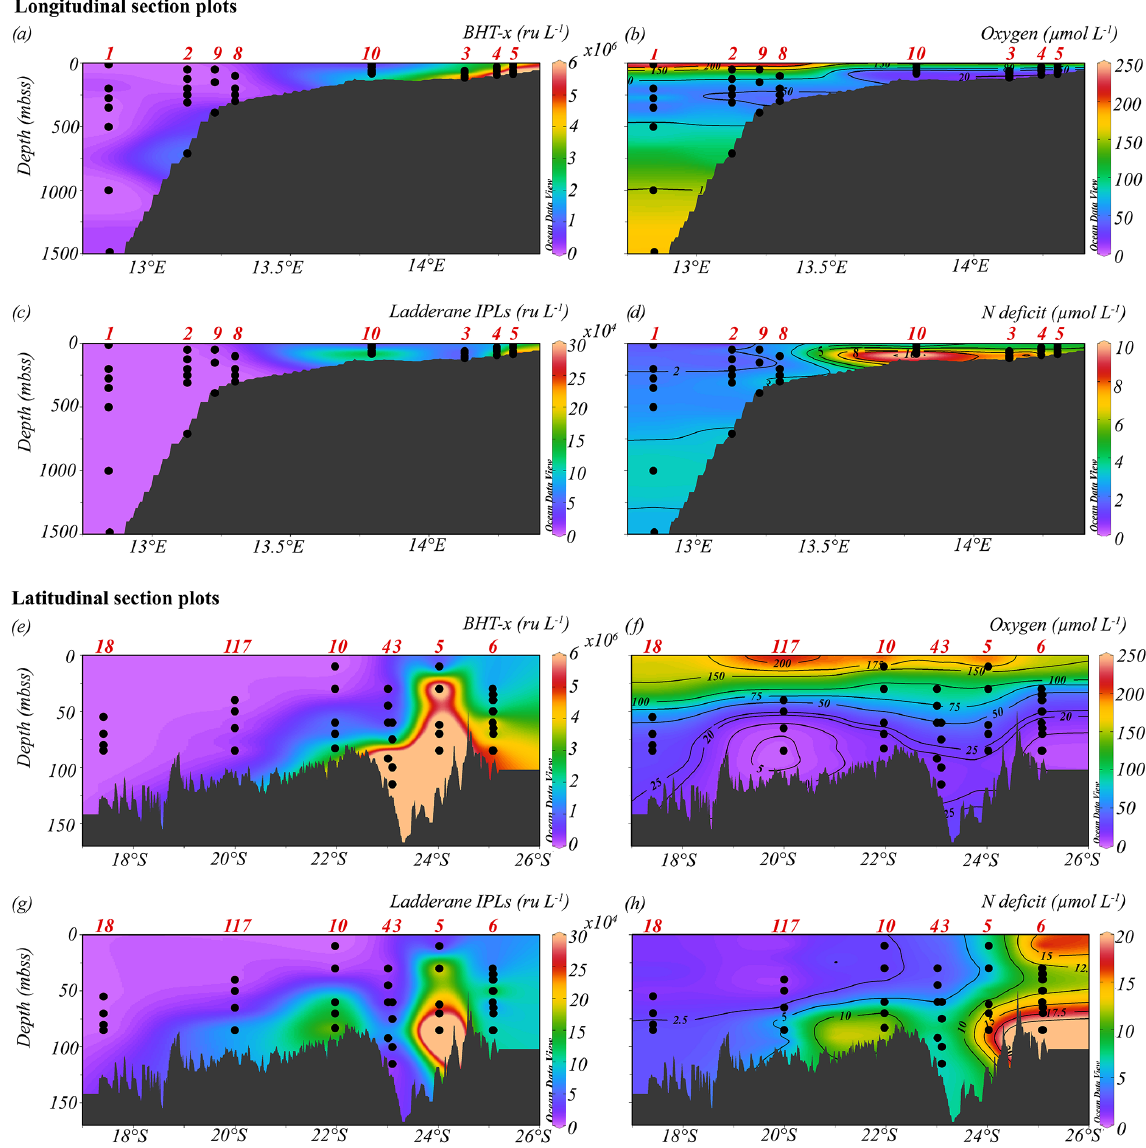
Figure 4. Longitudinal (a–d) and latitudinal (e–h) section plots showing interpolated concentrations of (a, e) BHT- x (ruL − 1 ), (b, f) dissolved oxygen (µmolL − 1 ), (c, g) ladderane IPLs (ruL − 1 ) and (d, h) nitrogen deficit (µmolL − 1 ). Contour lines for O 2 and N deficit concentrations are